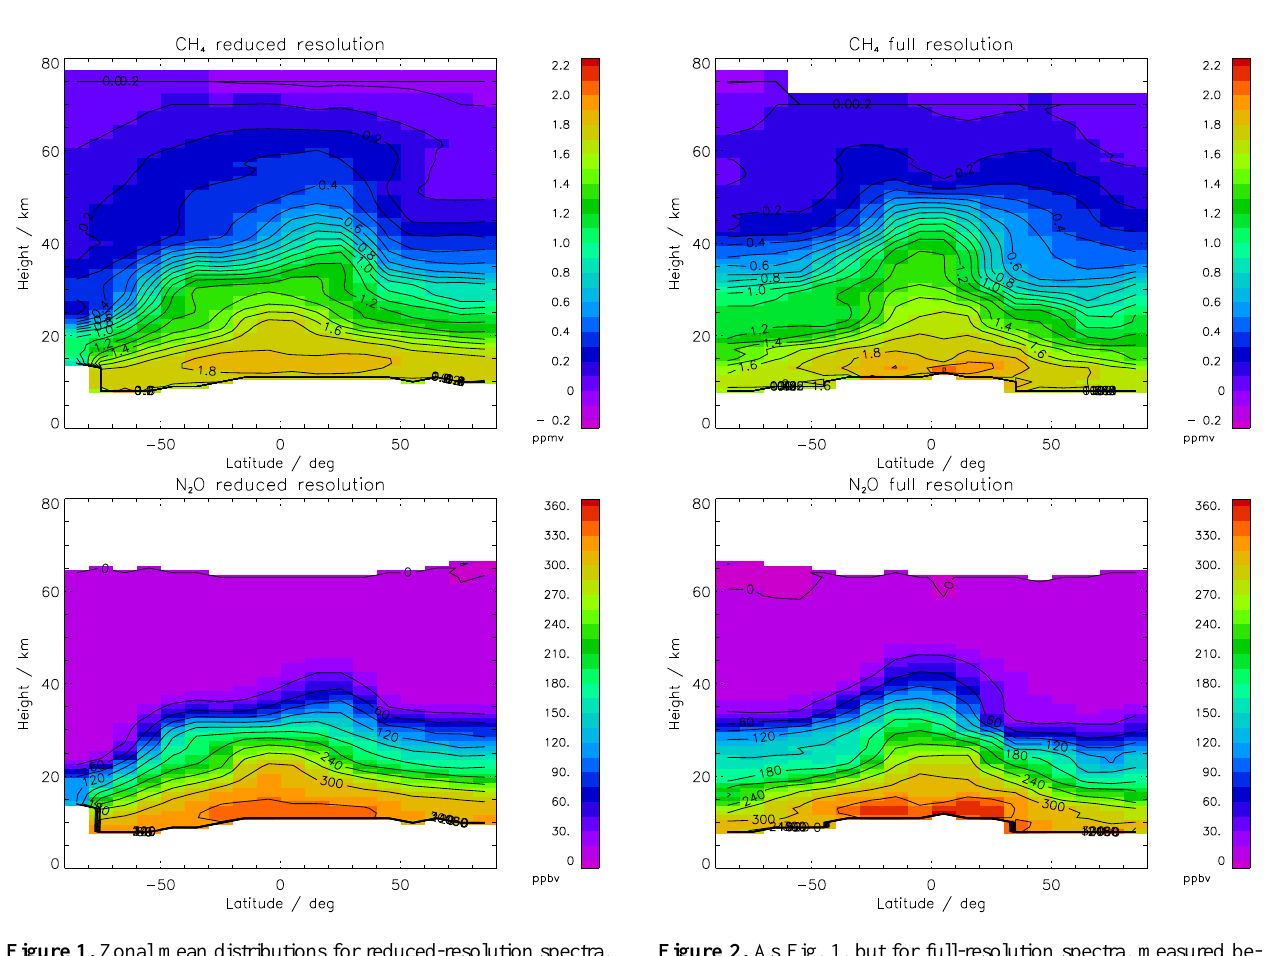
1 Figure 1. Zonal mean distributions for reduced-resolution spectra, 1 Figure 2. As Fig. 1, but for full-resolution spectra, measured be- measured between 5 June and 18 August 2010. The black lines tween 10 January and 20 February. The upper panel shows results are the interpolated isopleths. White areas show regions with no for CH 4 (version V5H_CH4_21); the lower panel shows results for valid data at all. The upper panel shows results for CH 4 (version N 2 O (version V5R_CH4_224); the lower panel shows results for N 2 O (version V5R_N2O_224).